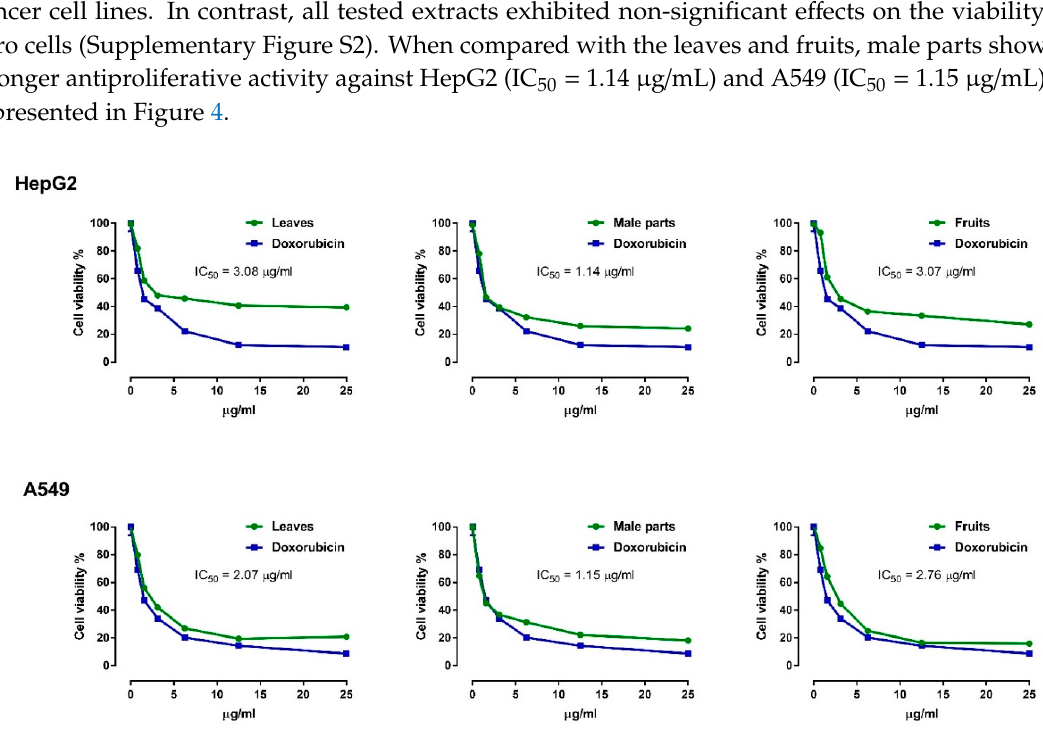
Figure 4. Antiproliferative activity of H. thebaica leaves, male parts and fruits against HepG2 and A549 cancer cell lines. Data are mean ± SD, N = cancer cell lines. Data are mean ± SD, N = 3.